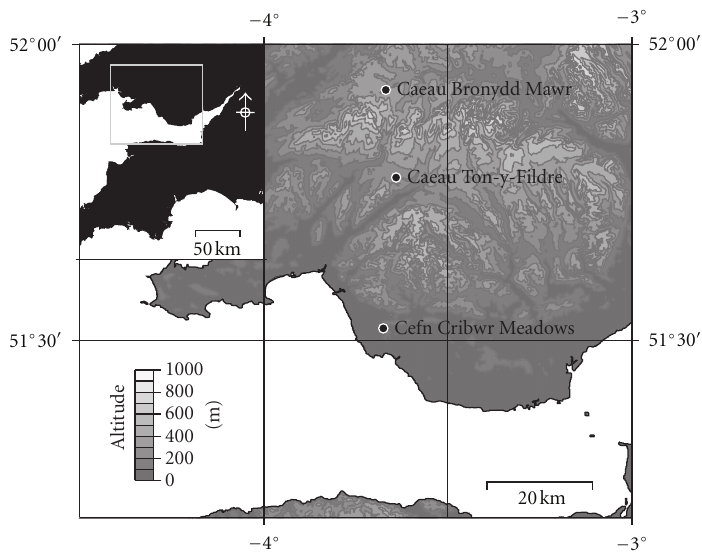
Figure 1: Map of Welsh sites: Caeau Ton-y-Fildre, Caeau Bronydd Mawr, and Cefn Cribwr Meadows.